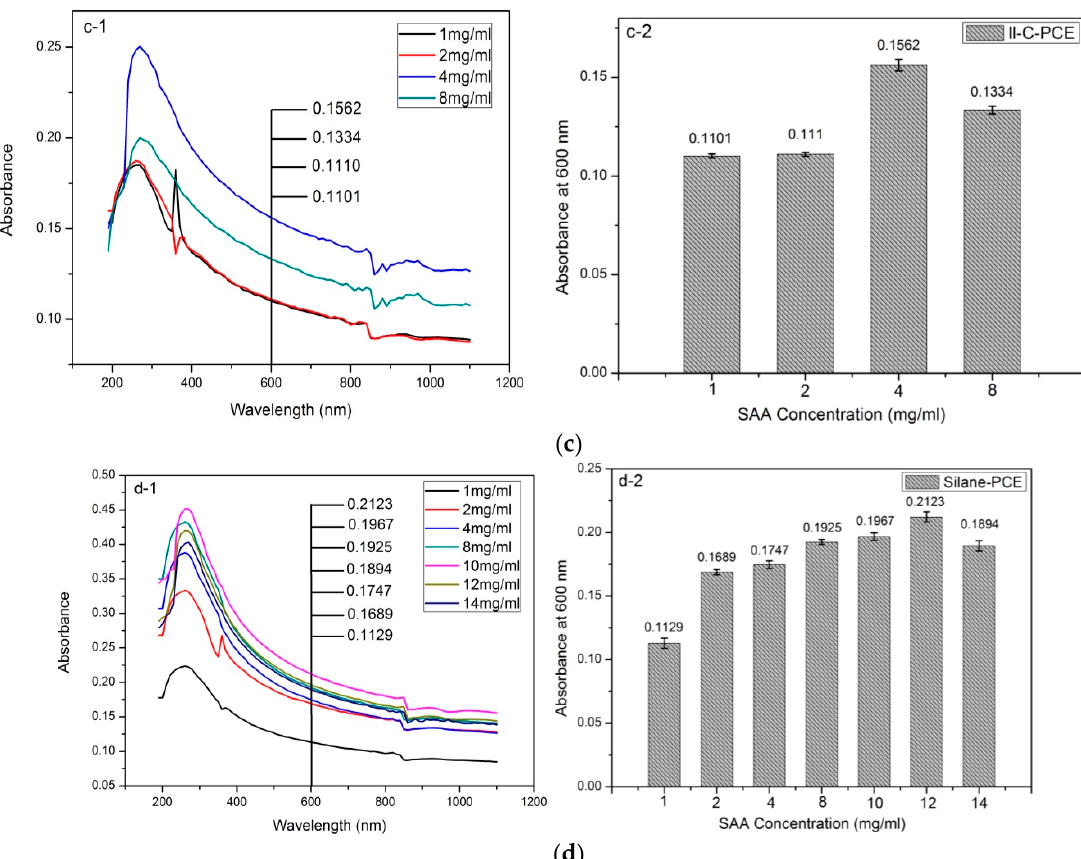
Figure 7. UV–Vis spectra of MWCNTs–OH dispersions with ( a ) APEO; ( b ) I-C-PCE; ( c ) II-C-PCE; and, ( d ) Silane-PCE, and absorbance at 600 nm vs. different SAA concentrations.“1”in the figures illustrates the UV–Vis spectra of MWCNTs–OH suspensions manufactured by varying categories and concentration of surfactant solutions; “2” in the figures demonstrates the Lambert-Beer absorbance value at 600 nm depend on the concentration of the surfactants.